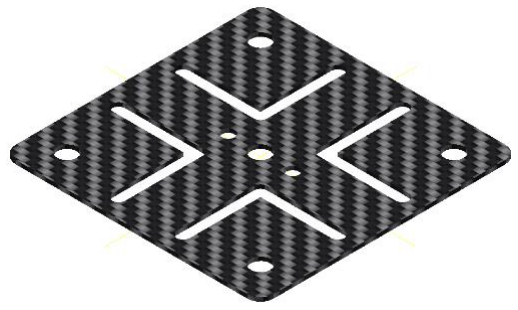
Figure 5. CFRP movement carrier, version 3.